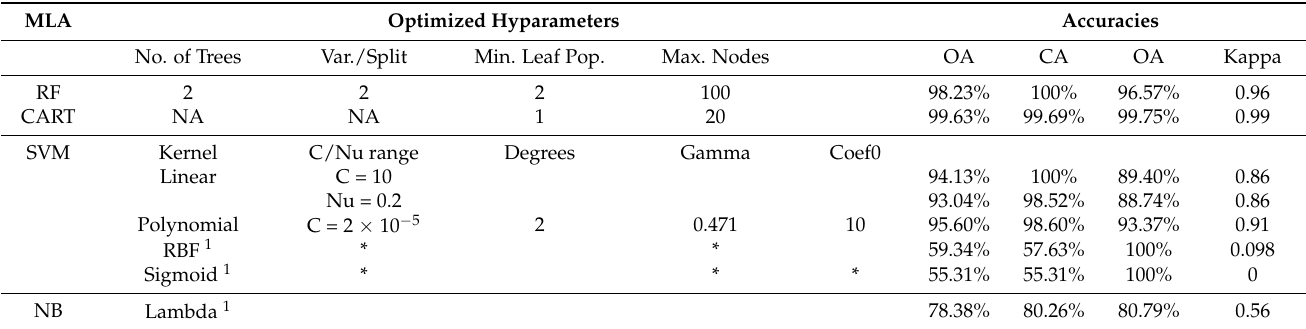
Table 5. CART, random forest, naïve Bayes, and SVM overall, consumer, and producer accuracies and kappa coefficient using Landsat-8 data with optimum hyperparameters for binary limestone classification. MLA